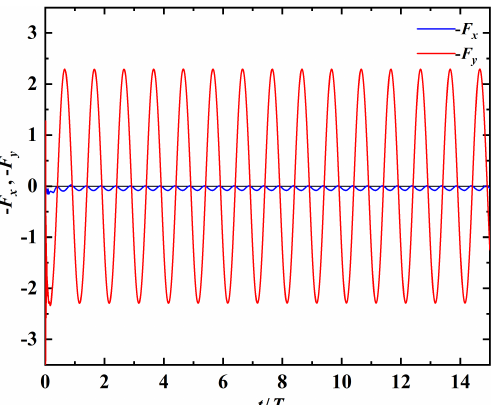
Figure 3. Time histories of the leading-edge’s horizontal ( a ) and vertical ( b ) velocity components in straight − line swimming.